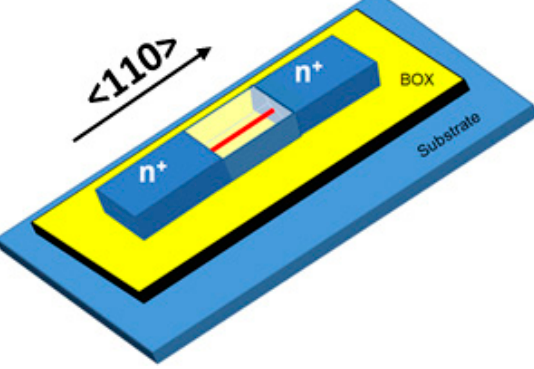
Figure 27. Schema of an n + pn + diode structure with a dislocation (red line) in the channel (c). Devices are fabricated parallel to <110> directions, i.e., parallel to the dislocation line direction.